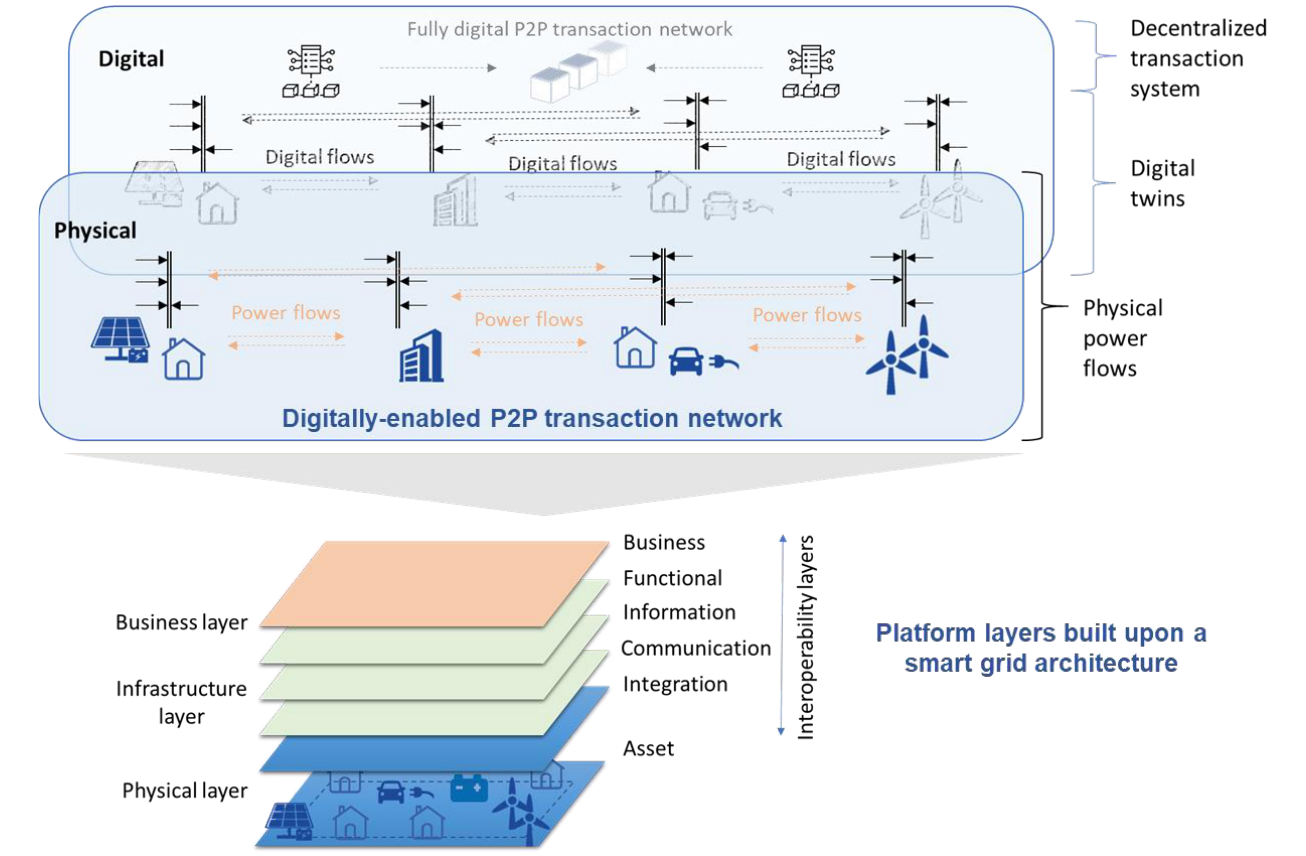
Figure 7. Digitally-enabled transaction network as a basic layer of the smart grid platform. Power Sector’s AI Adoption